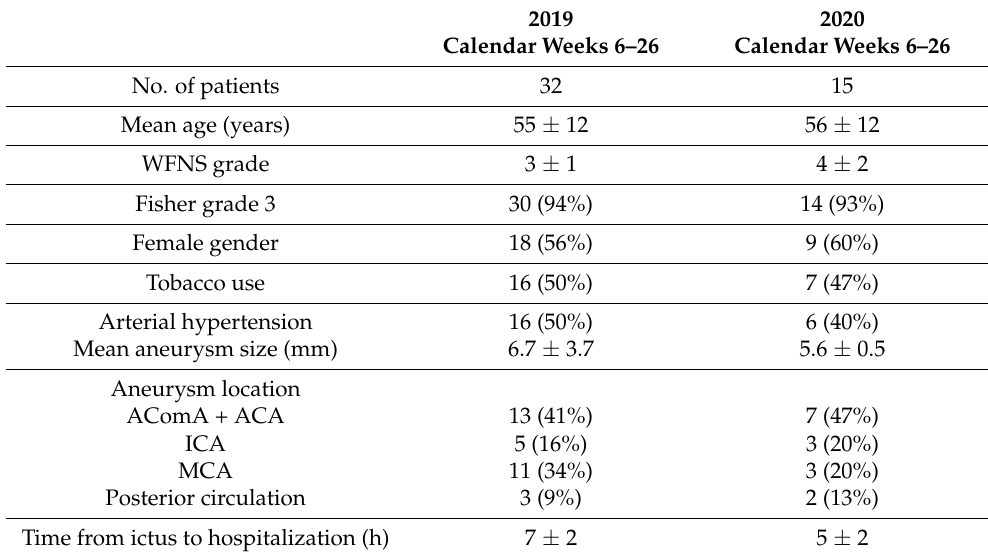
Table 1. Baseline characteristics of patients with aneurysmal subarachnoid